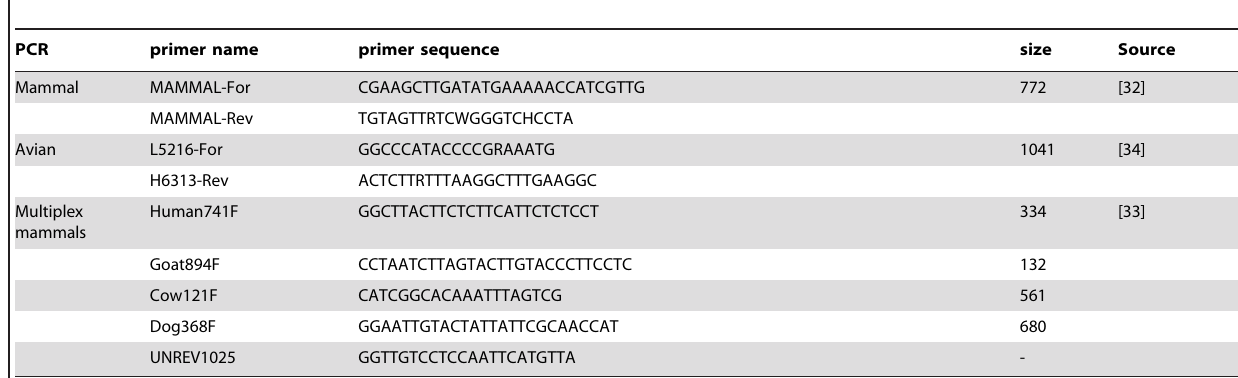
Table 1. Primer sequences used for the blood meal identification